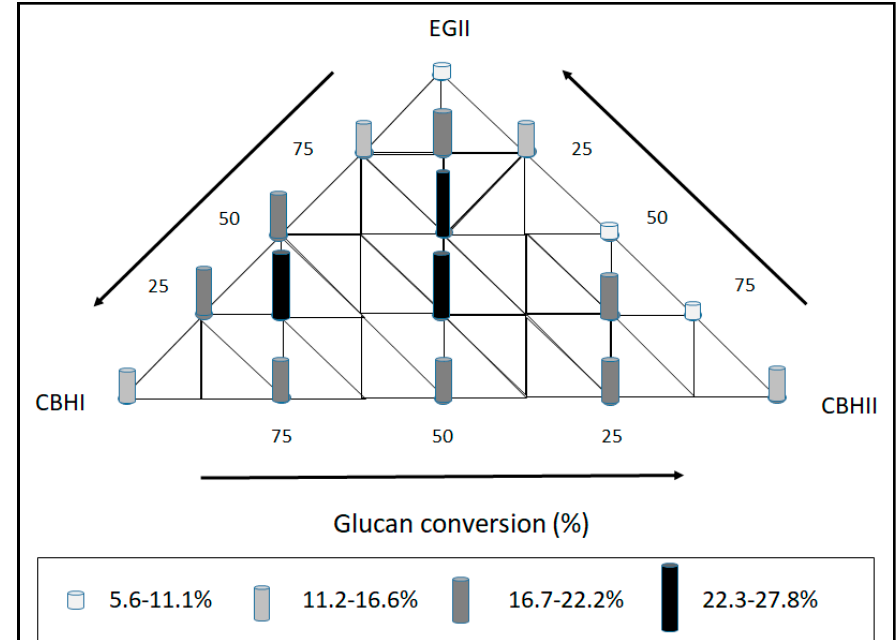
Figure 3. Glucose yields obtained from the optimisation of the formulated cellulase cocktail ( Te Cel7A (CBHI), Cl Cel6A (CBHII) and Tr Cel5A (EGII)) on the hydrolysis of 2% ( w / v , dry mass basis) paper sludge for 48 h at 50 °C, at a protein loading of 1.875 mg/g biomass with Pc BGL1B (BGL) at 10% protein loading. All experiments were performed in quadruplicate and the mean values were calculated. The different shades of the bars indicate data sets that exhibited differences which were statistically significant (one-way ANOVA, p < 0.05).